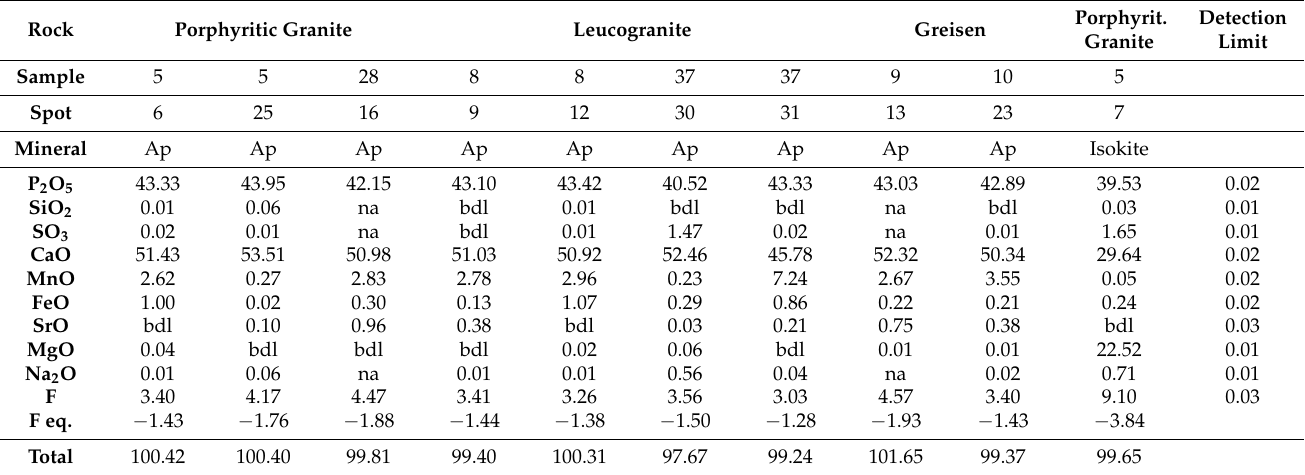
Table 6. Chemical composition (wt.%, EMPA) and empirical formulae of apatite. All Ce-values below detection limit (bdl) of 0.03 wt.% Ce 2 O 3